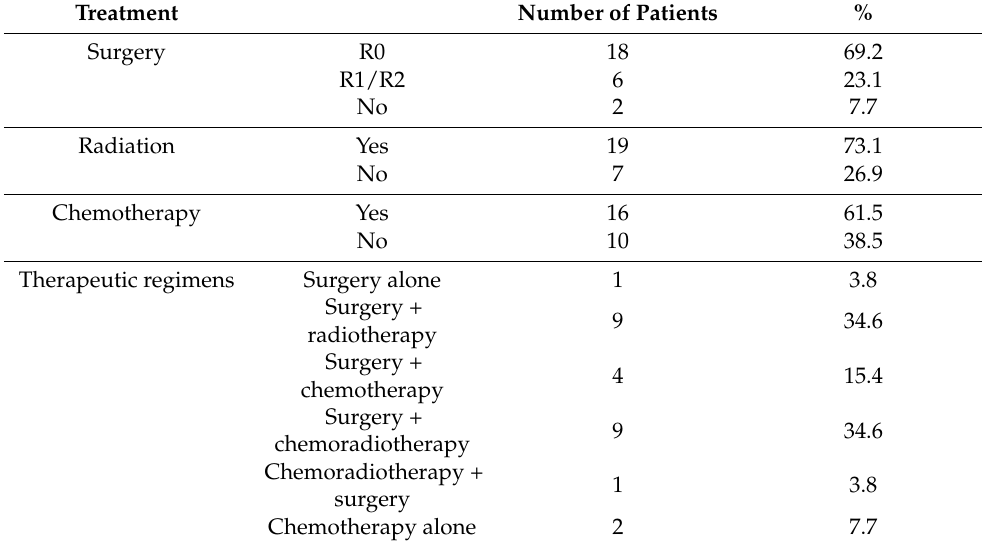
Table 2. Treatment